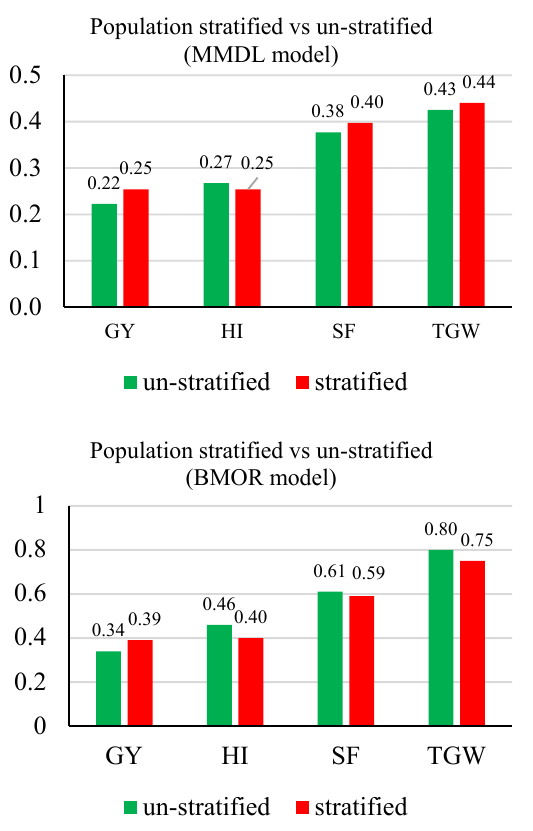
Figure 4. Average prediction accuracies for GY, HI, SF, and TGW with/without population stratified for five models. GY, grain yield; HI, harvest index; SF, spike fertility; TGW, thousand grain weight. Mean Pearson’s correlations for each trait were presented and labeled. The stratified scheme was colored in green, and the un-stratified scheme was colored in red.